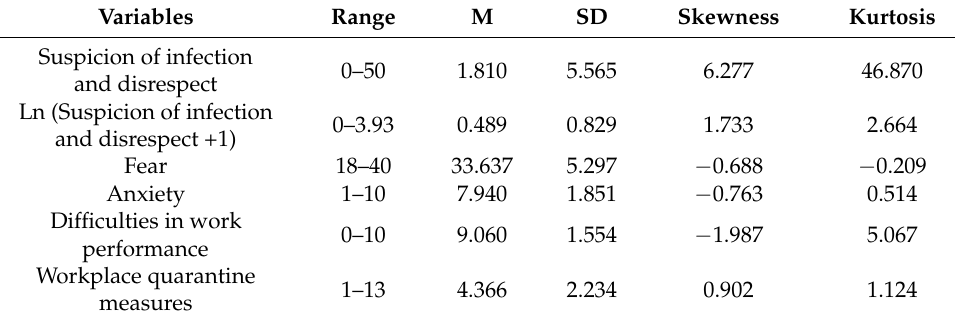
Table 1. Descriptive statistics of